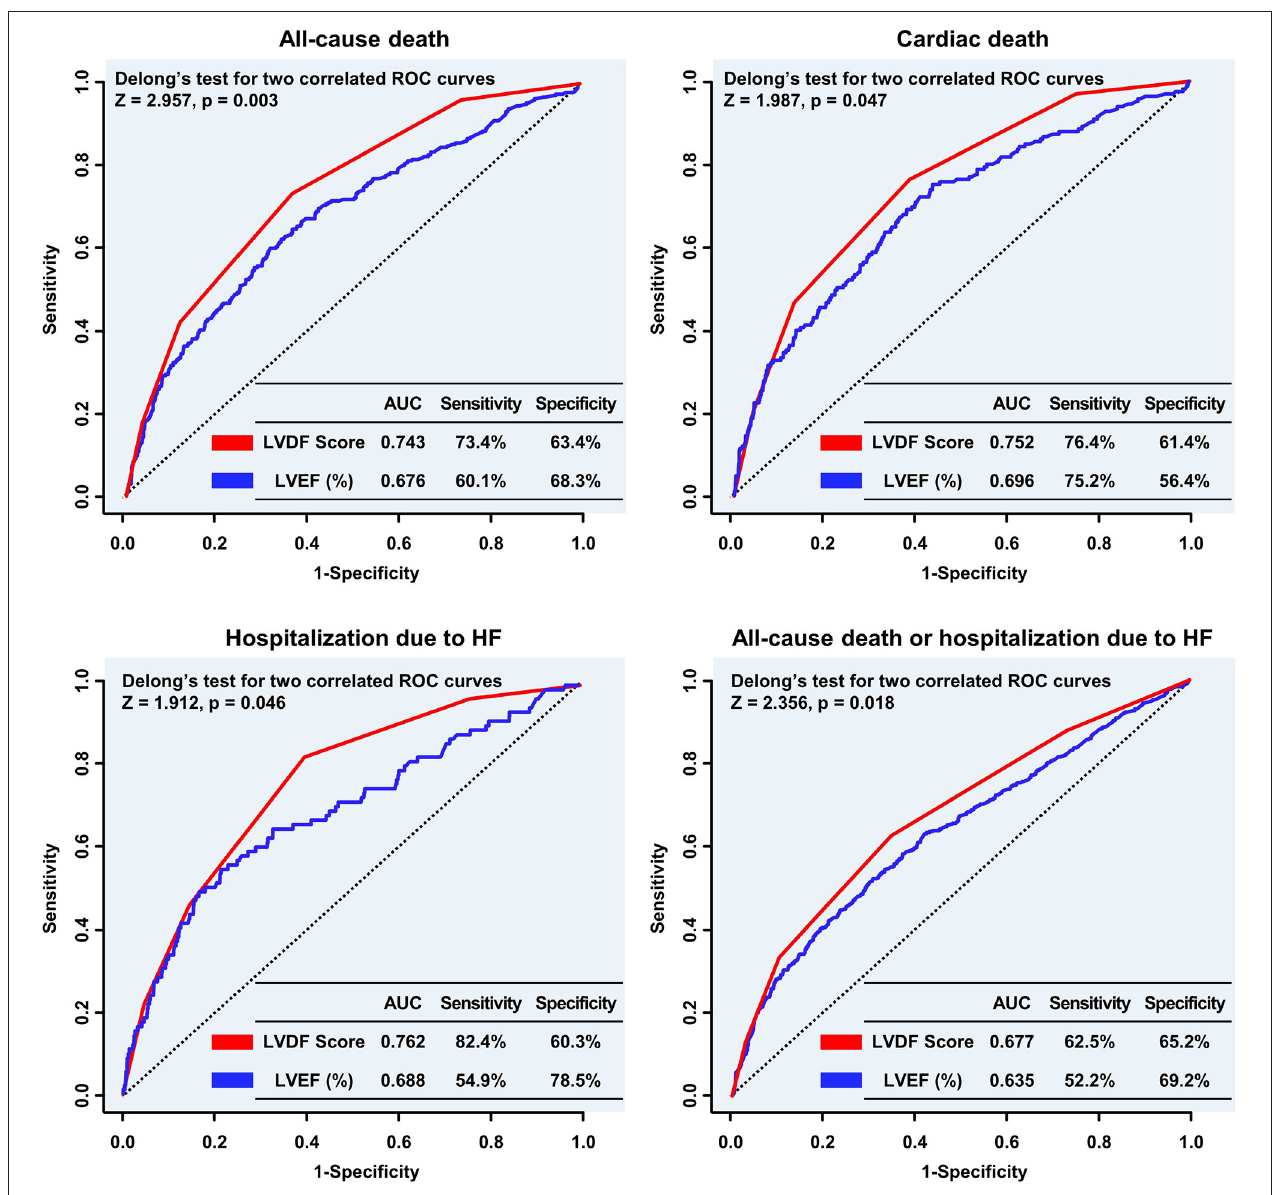
FIGURE 4 | Comparison of the predictive performance of the LVDF score and LVEF for clinical outcomes. The LVDF score performed significantly better in predicting all-cause mortality, cardiac death, and hospitalization due to HF compared with LVEF. AUC, area under the receiver operating characteristic curve; HF, heart failure; LVDF, left ventricular diastolic function; LVEF, left ventricular ejection fraction; ROC, receiver operating